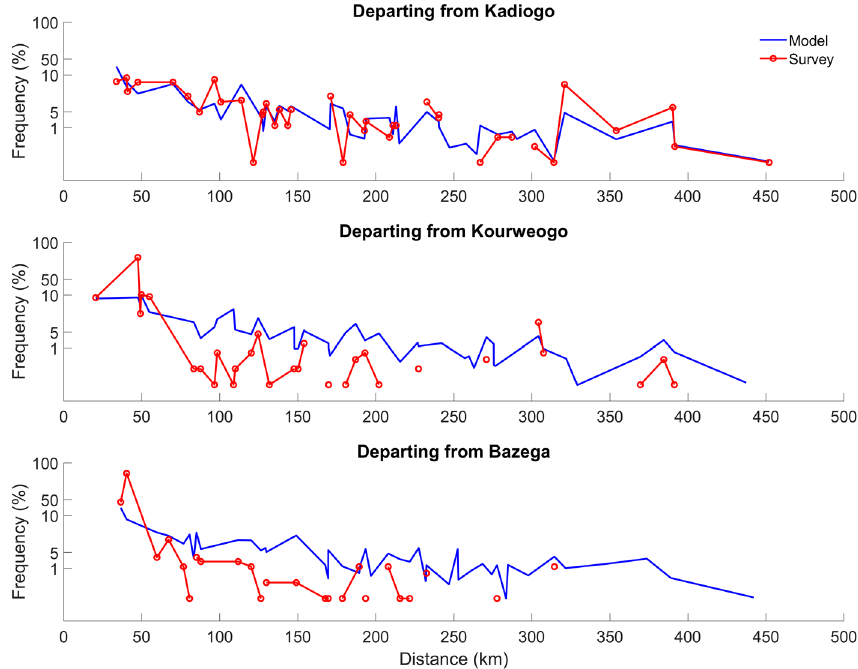
Figure 4. Trips from Kadiogo providence compare favorably with the Marshall et al. 17 survey on the basis of distance traveled. However, the limited survey data for Kourweogo and Bazega pose a challenge to model validation, although the simulated results are generally consistent with the survey